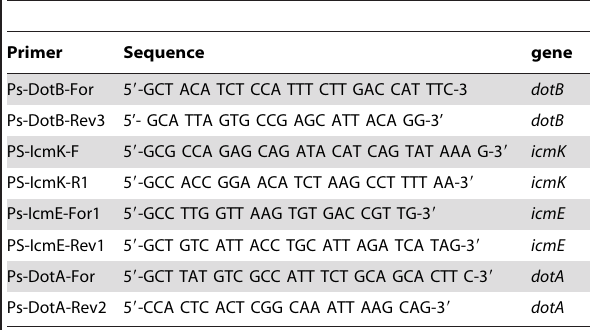
Table 2. Specific primers for P. salmonis dot/icm genes used for